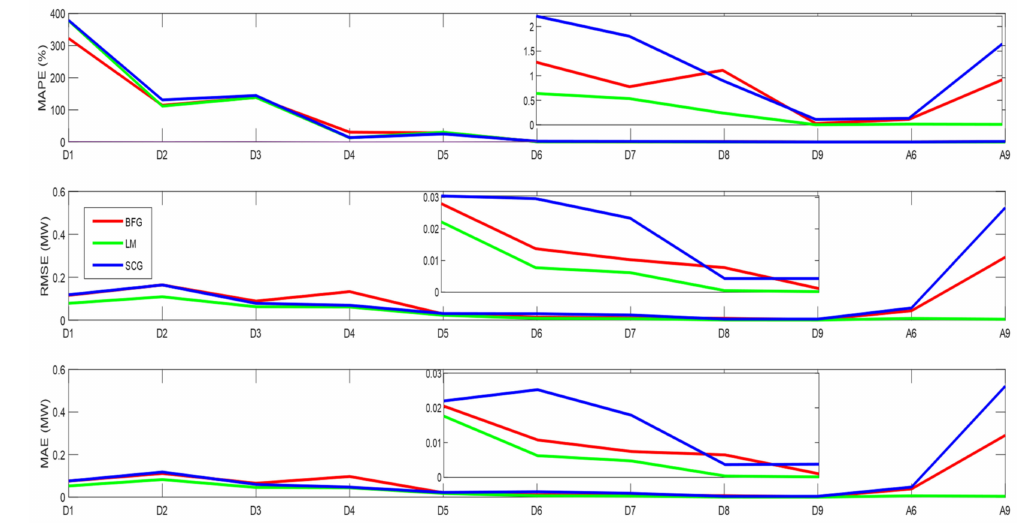
Figure 10. MAPE, RMSE, and MAE performance of the training